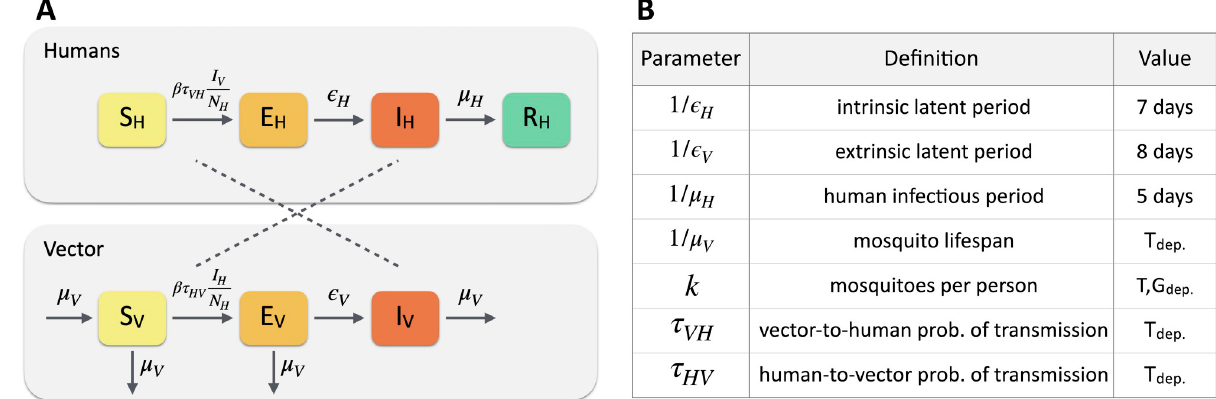
Fig 2. Epidemic modelling framework. (A) The disease dynamics occurs according to a compartmental classification for ZIKV infection. Humans classification, whereas mosquitoes follow a susceptible-exposed-infectious (SEI) follow a susceptible-exposed-infectious-removed (SEIR) H transmission dynamics of ZIKV occurs through the interaction between susceptible humans S H and infected mosquitoes I V , and between infected and susceptible mosquitoes S . (B) Summary of epidemiological parameters: T denotes parameters that are temperature-dependent. humans I H V dep . T , G dep . denotes parameters that are temperature- and geolocation-dependent. Specific values for the parameters can be found in Refs. [39, 41–43]